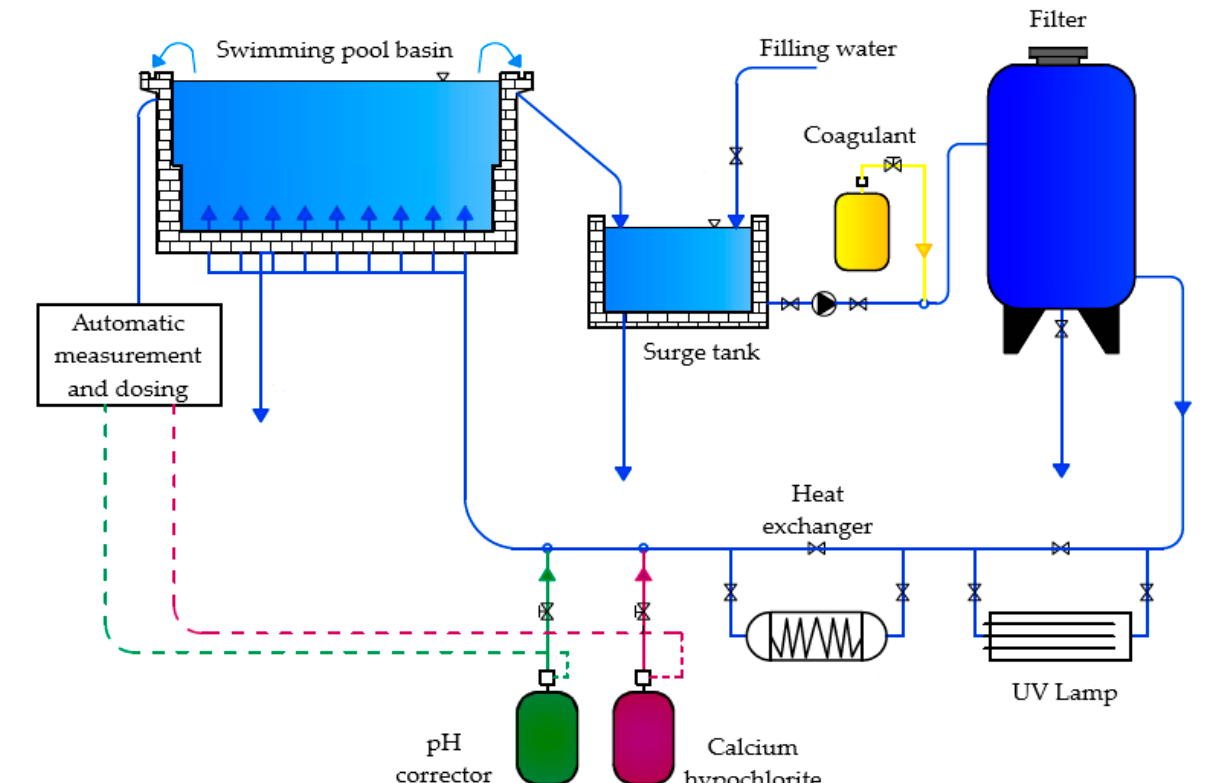
Figure 1. Scheme of the swimming pool water treatment in the study facility, with the localization of the UV lamp.